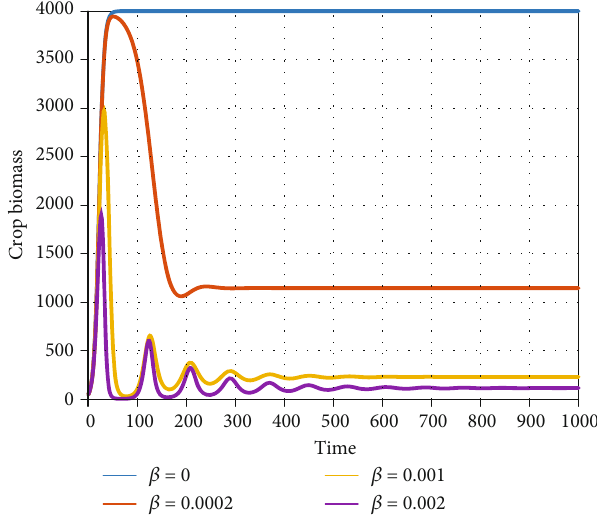
Figure 4: Impact of integrated early intervention on total desert locust population. The simulation was conducted in the absence of intervention ( θ = θ intervention ( θ = 0 : 0025 , θ